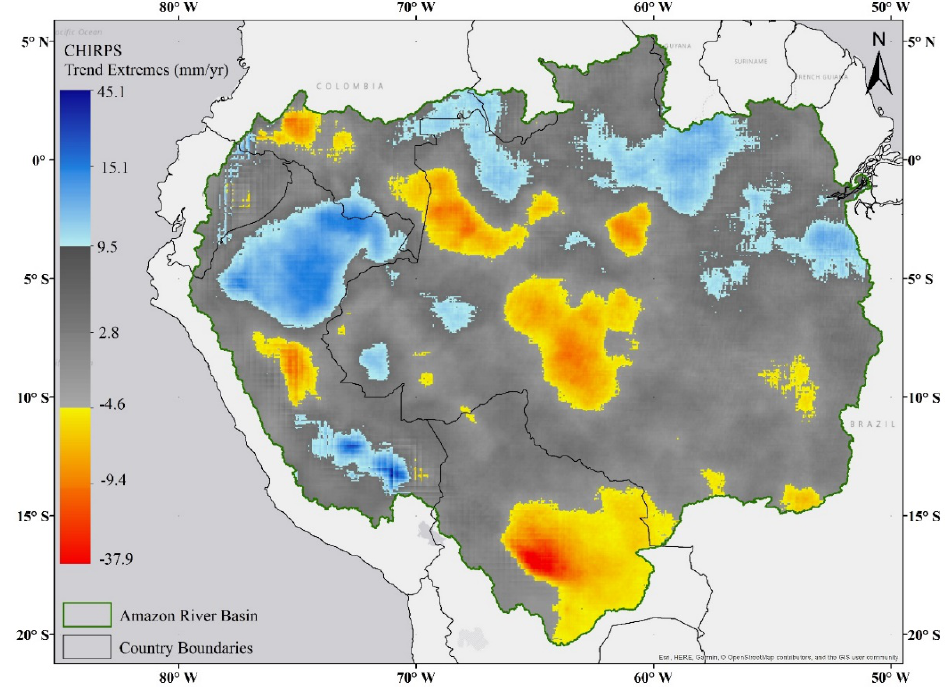
Figure 9. Clusters of increasing precipitation trends above the 85th percentile (blue) from 9.5 to 45.1 mm/year and clusters of decreasing precipitation below the 15th percentile between −4.6 to −31.9 mm/year using 37 years of the CHIRPS precipitation product.